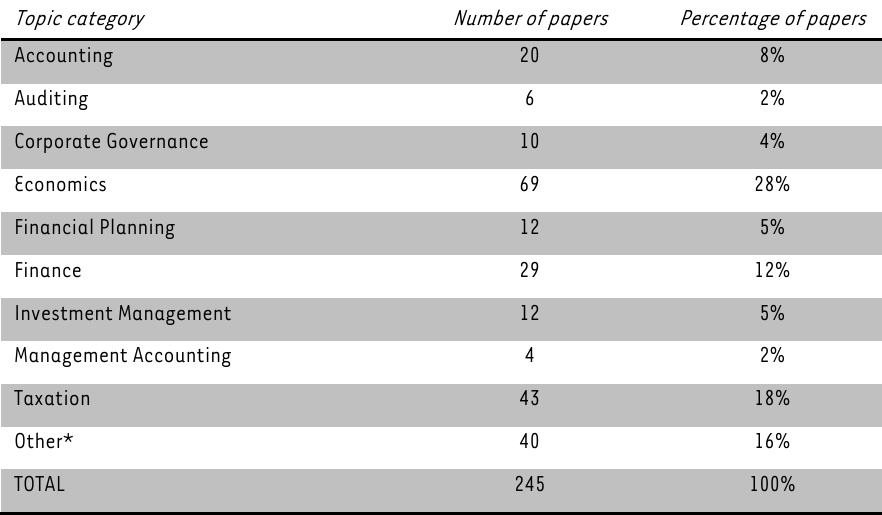
TABLE 10: Content analysis of topic categories in